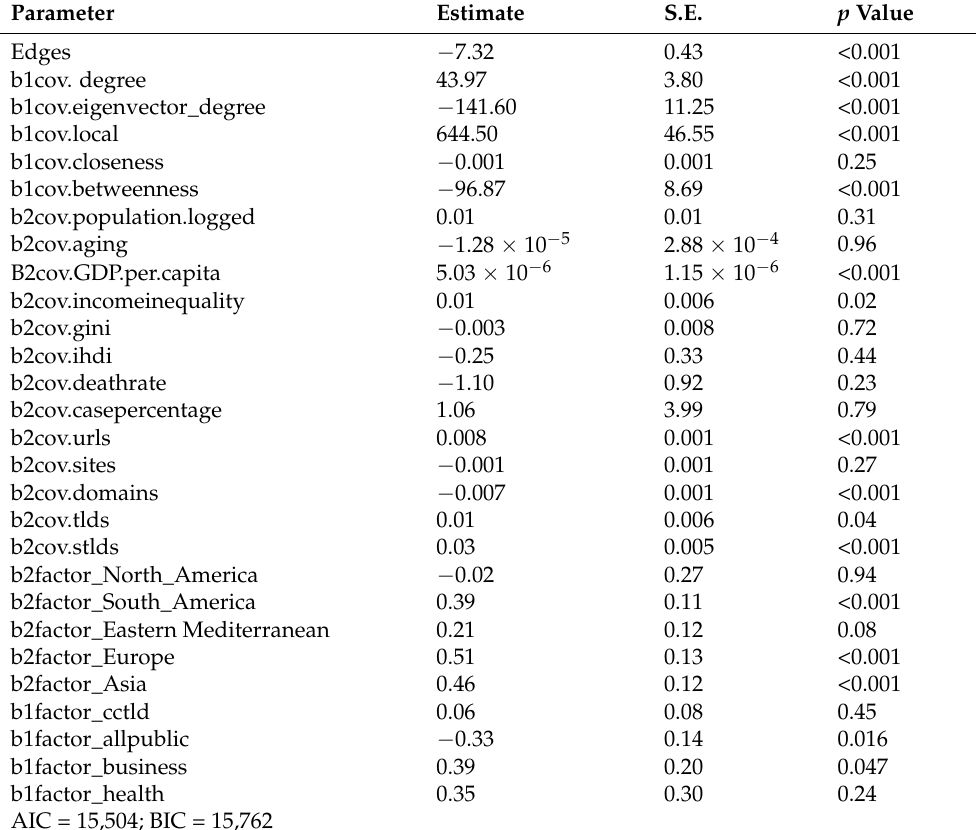
Table 3. Results from the bipartite